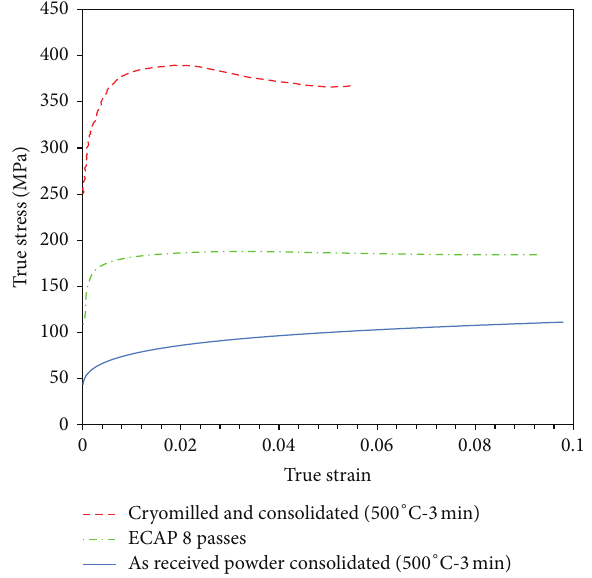
Figure 11: True stress strain response in simple compression for consolidated samples from the 7 hrs cryomilled powders. The heating rate used for this sample was 800 ∘ C/min. Also shown in the figure are the true stress strain responses for as-received powder consolidated at 500 ∘ C for 3min., and an ECAPed specimen